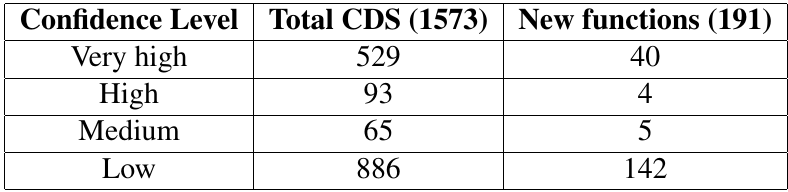
Table 2: Confidence levels of function assignment to total and new functions